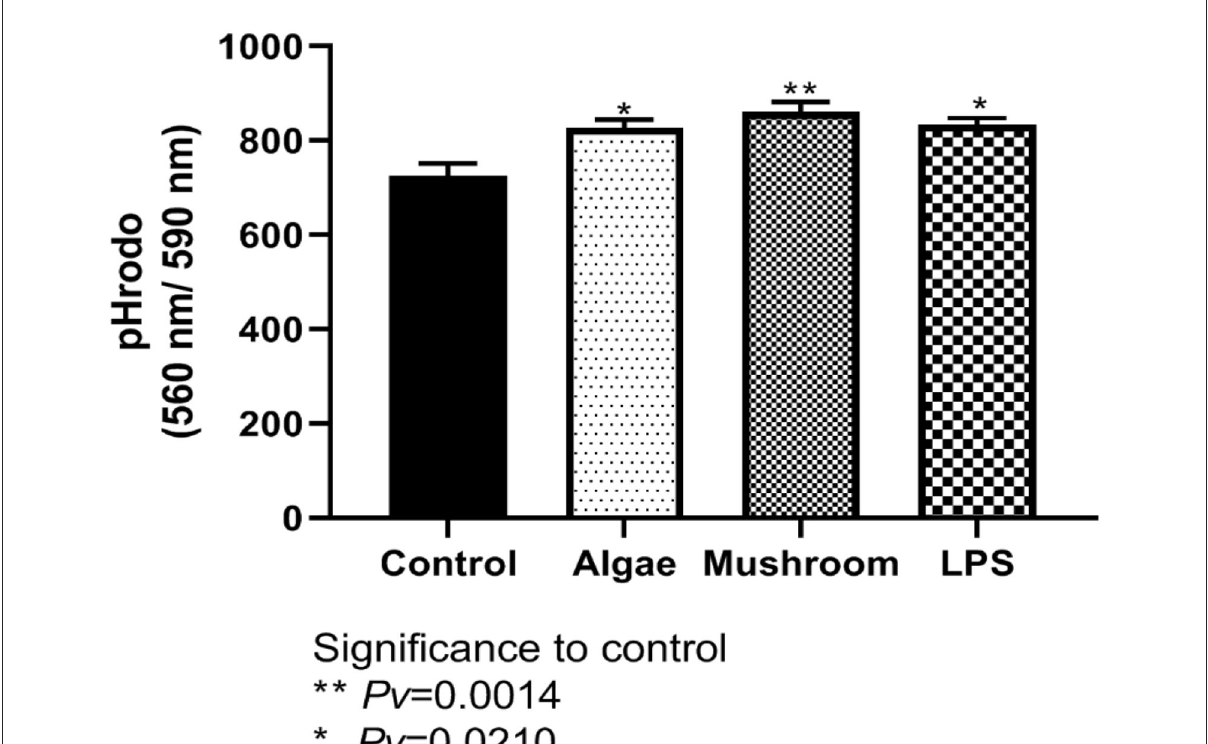
FIGURE6 Measured phagocytosis activity after 60min. HD11 cell line were incubated for 1h with 1 mg/ml of either mushrooms or algae beta-glucans (n = 6), or 100ng/ml of LPS (n = 3) and compared to control (n = 3).